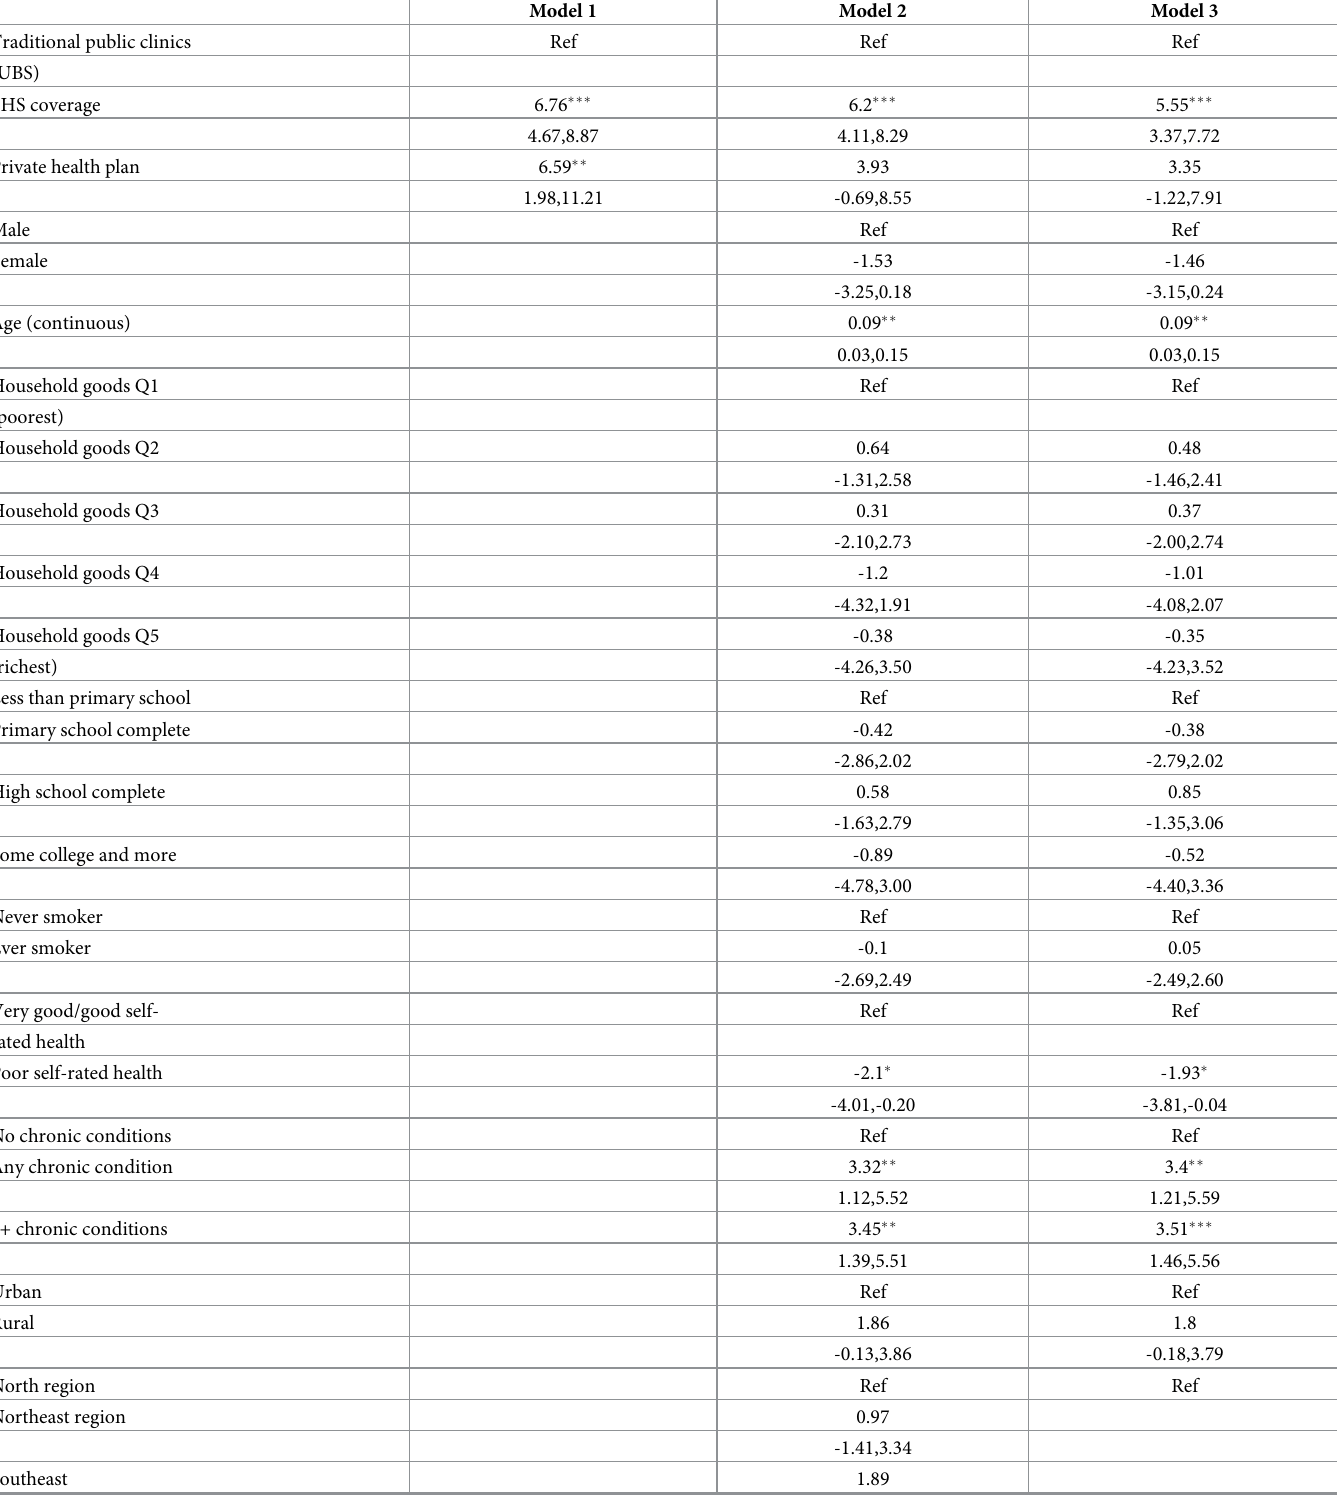
Table 3. Regression analyses of the association between respondents’ individual characteristics and their primary care experiences (PCAT